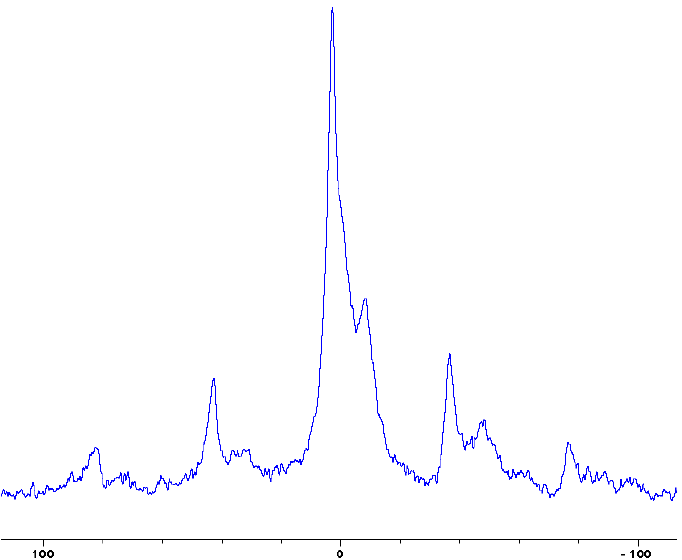
Figure 2. Solid-state 31 P-NMR spectrum of char obtained from fish gelatin + triphenylphosphineoxide (TPPO) (the abscissa denotes the chemical shift values, δ , in ppm and the ordinate corresponds to the signal intensity in arbitrary units).